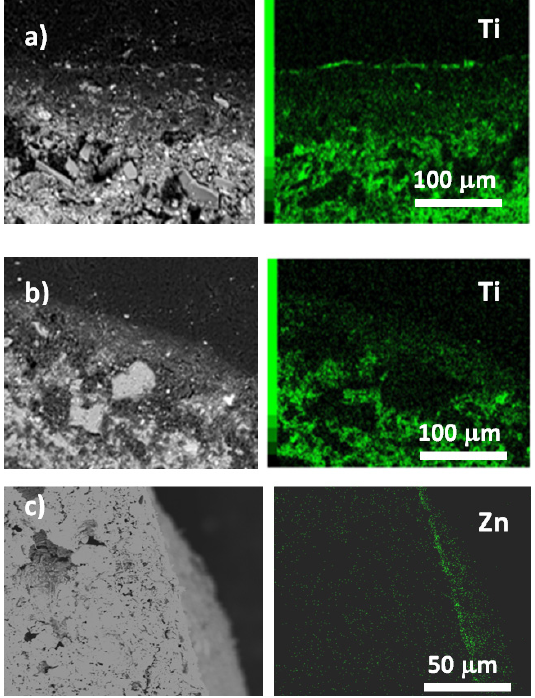
Figure 3. SEM-EDS images (SE/BSE on the left and EDS elemental map on the right) of: ( a ) MTN 94 coated with Pro-Art (TiO 2 ), it is visible a continuous layer of TiO 2 on the top ( b ) MTN 94 coated with Pro-Art (TiO 2 ) with vandal layer, there is not any visible layer of TiO 2 on the top ( c ) MTN 94 coated with PRO-ART, the Zn map suggests a homogeneous distribution of the coating on the surface.